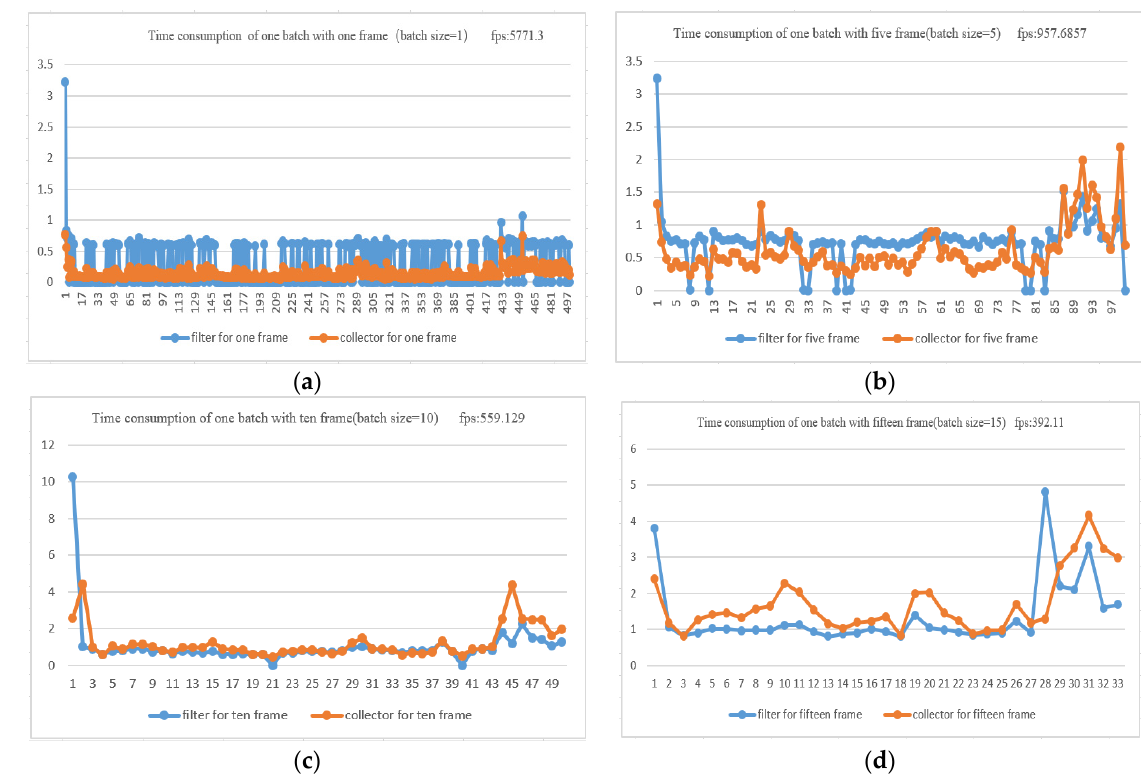
Figure 9. Time consumptions of different batch sizes: ( a ) the batch size was 1; ( b ) the batch size was 5; ( c ) the batch size was 10; ( d ) the batch size was 15.